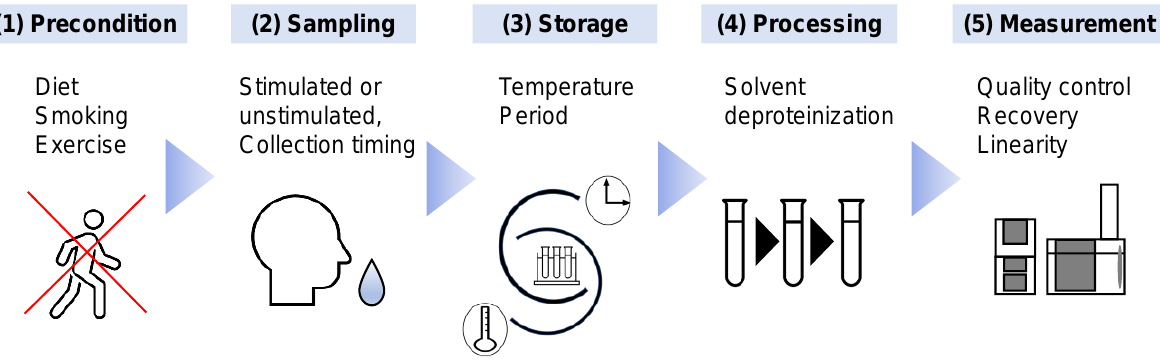
Figure 2. The factors influencing salivary metabolomics that require the establishment of standard operating procedures are shown. (1) As preconditions before saliva collection, the diet, smoking behavior, and intensive exercise of subjects should be restricted, as they potentially affect salivary metabolites. (2) To eliminate diurnal variation, stipulated timing of saliva collection, e.g., 9:00 – 11:00 am, should be implemented. The selection of stimulated or unstimulated saliva is vital. (3) The tem- perature and duration of storage of the saliva samples should also be standardized. (4) Chemicals used as solvents and the methodology for deproteinization should be selected accurately. (5) Qual- ity assessment of the measurement device using quality control samples is vital to eliminate unex- pected bias.